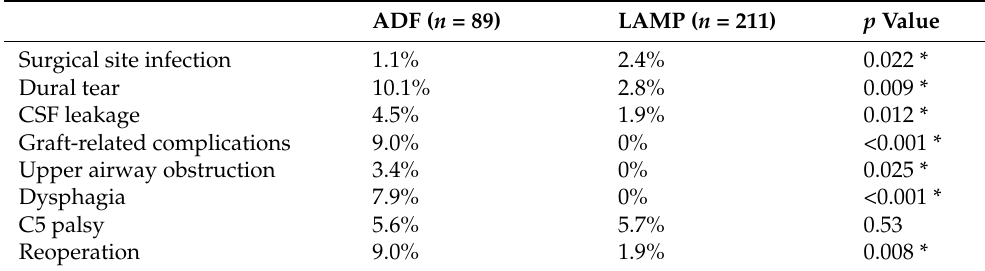
Table 2. Perioperative complications in ADF and LAMP (crude analysis).